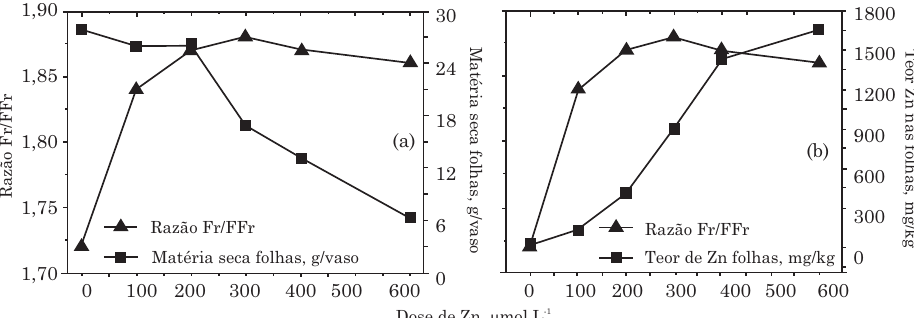
Figura 4. Razão dos espectros de fluorescência de clorofila aos 28 dias e matéria seca das folhas (a); razão dos espectros de fluorescência de clorofila aos 28 dias e conteúdo de Zn das folhas